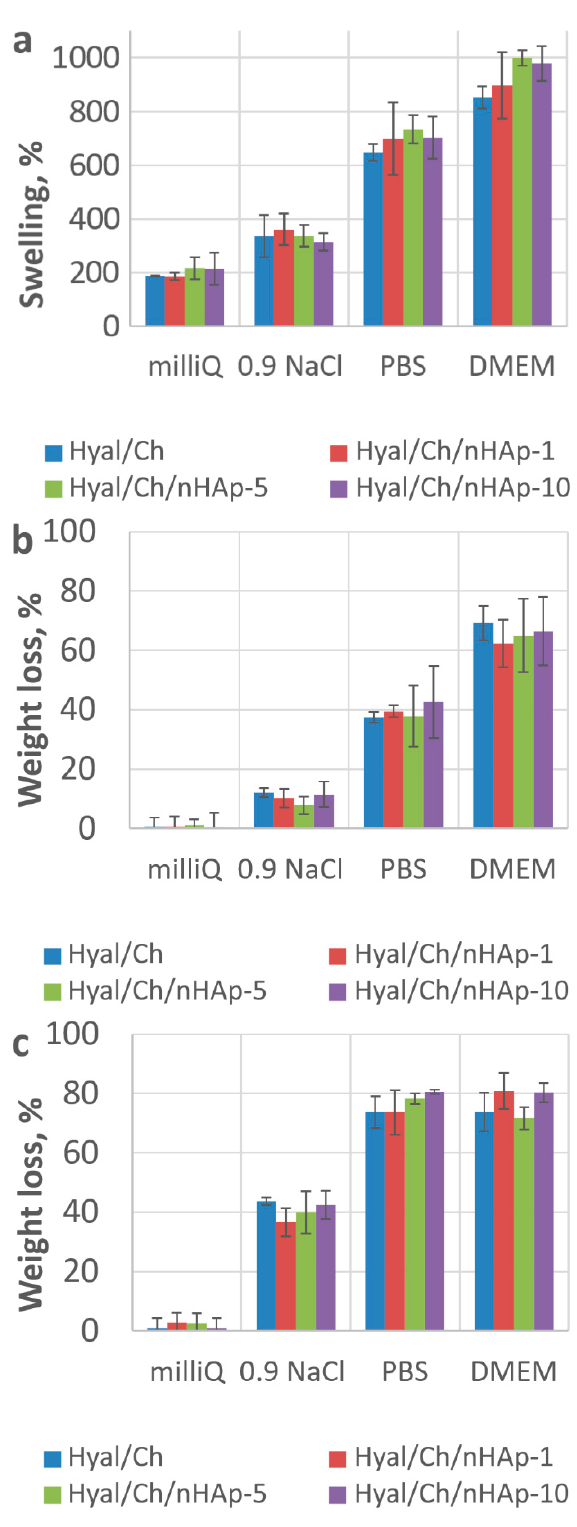
Figure 4. Swelling ratio after 24 h ( a ) and weight loss after 1 week ( b ) and 4 weeks ( c ) incubation of the hydrogel samples in various aqueous media. Hyal/Ch sample was without hydroxyapatite nanoparticles; Hyal/Ch/nHAp-1, Hyal/Ch/nHAp-5 and Hyal/Ch/nHAp-10 samples were loaded with 1, 5 and 10 wt. % of hydroxyapatite nanoparticles, respectively.